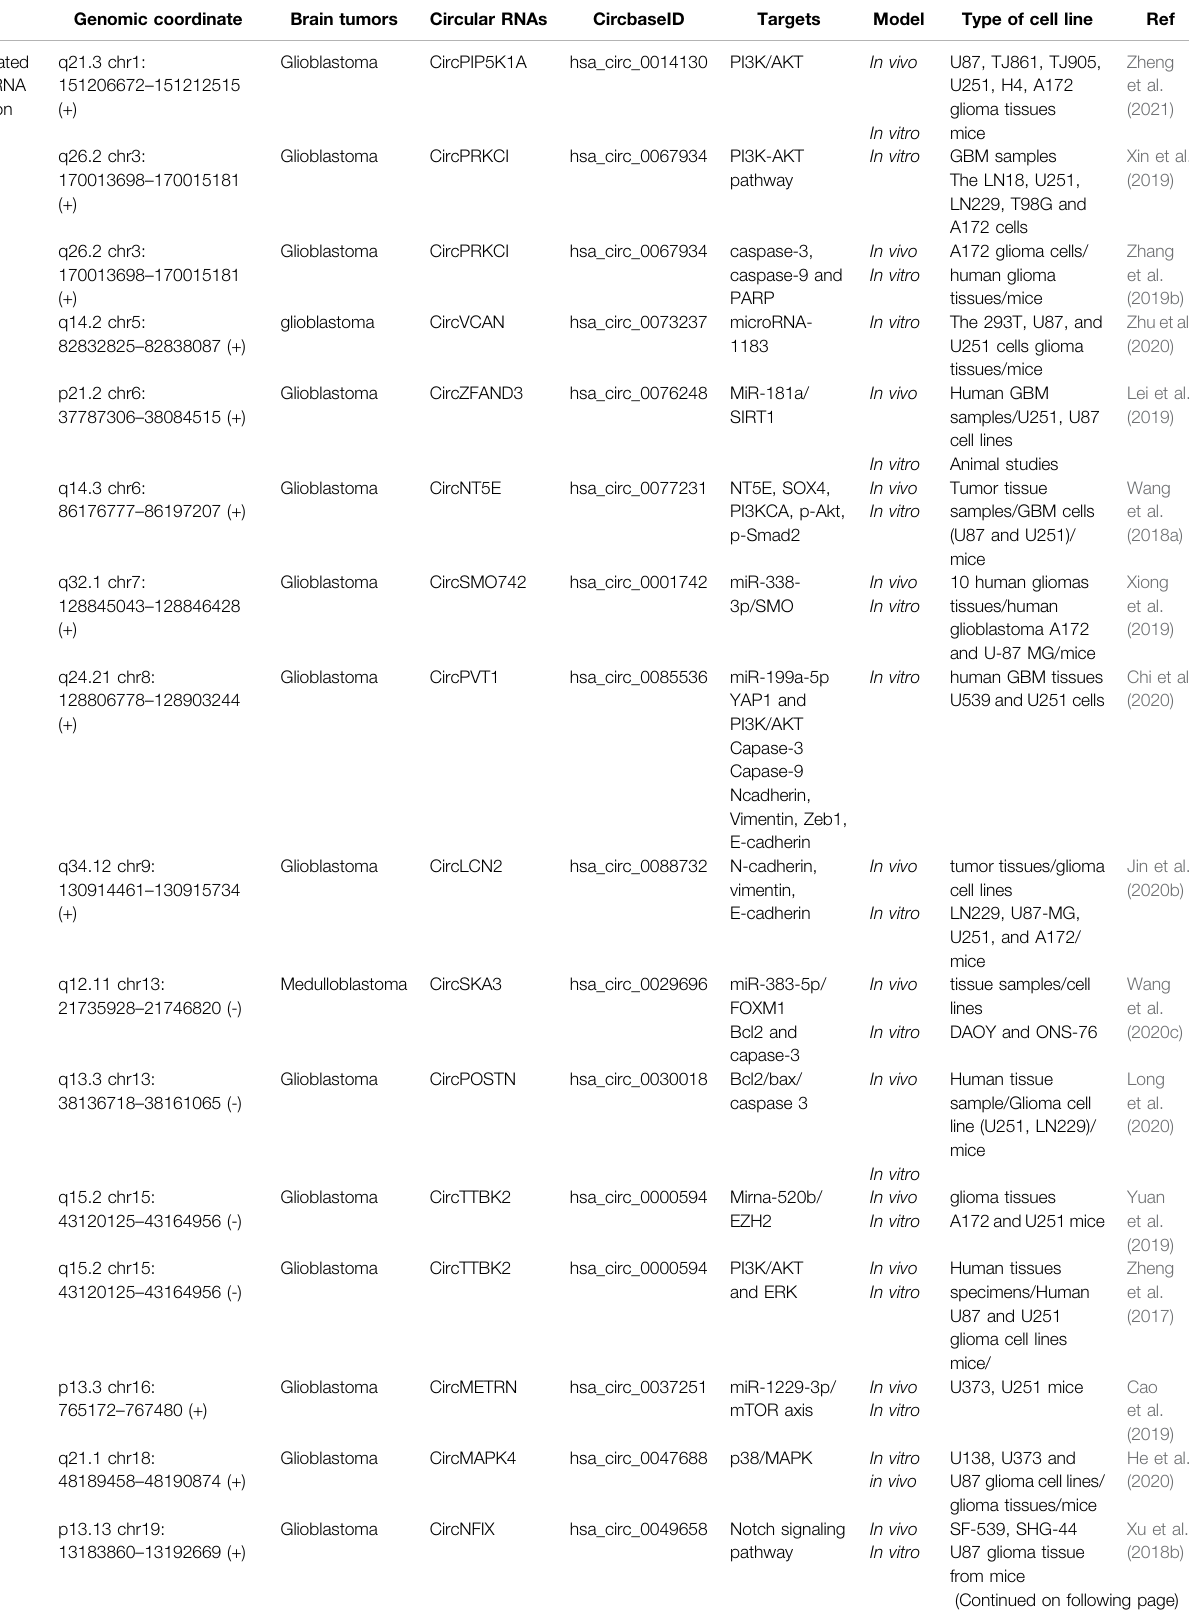
TABLE 3 | Apoptosis-related circular RNAs in brain